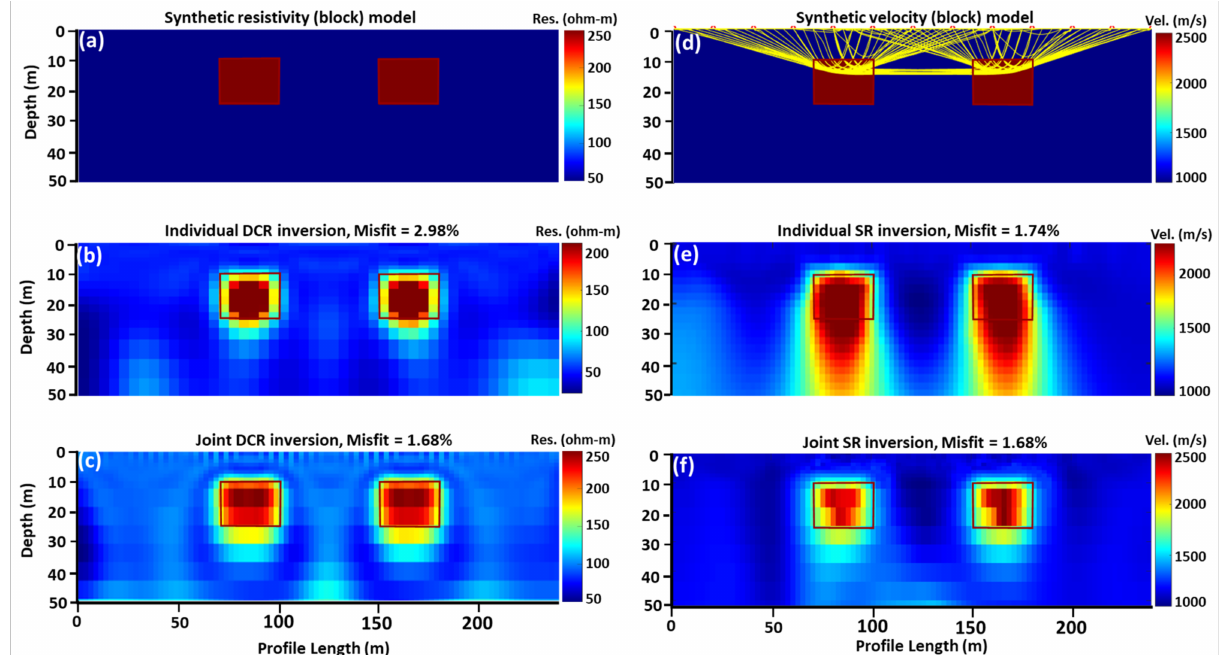
Figure 7. Positive anomaly model inversion using local optimization method; ( a ) synthetic dc- resistivity model, ( b ) individual inverted resistivity model, ( c ) joint inverted resistivity model, ( d ) synthetic velocity model and its ray path coverage, ( e ) individual inverted velocity model, and ( f ) joint inverted velocity model. The dark red line is used to mark the anomaly boundary.